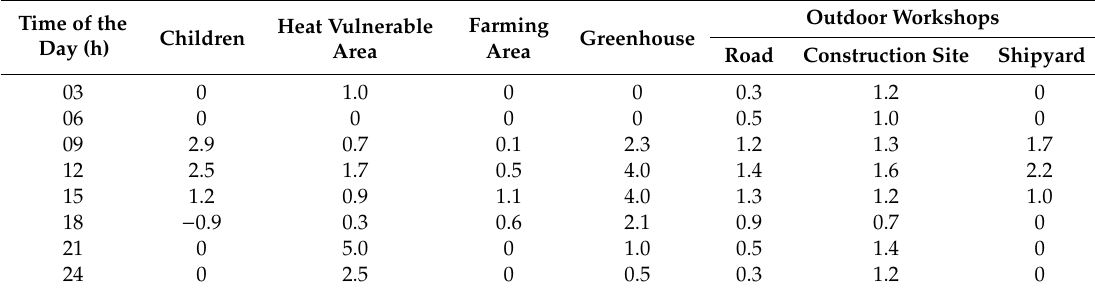
Table 2. Thermal comfort index ( TCI ) weighting values relative to the time of the day (KMA). Time of the Children Day (h)